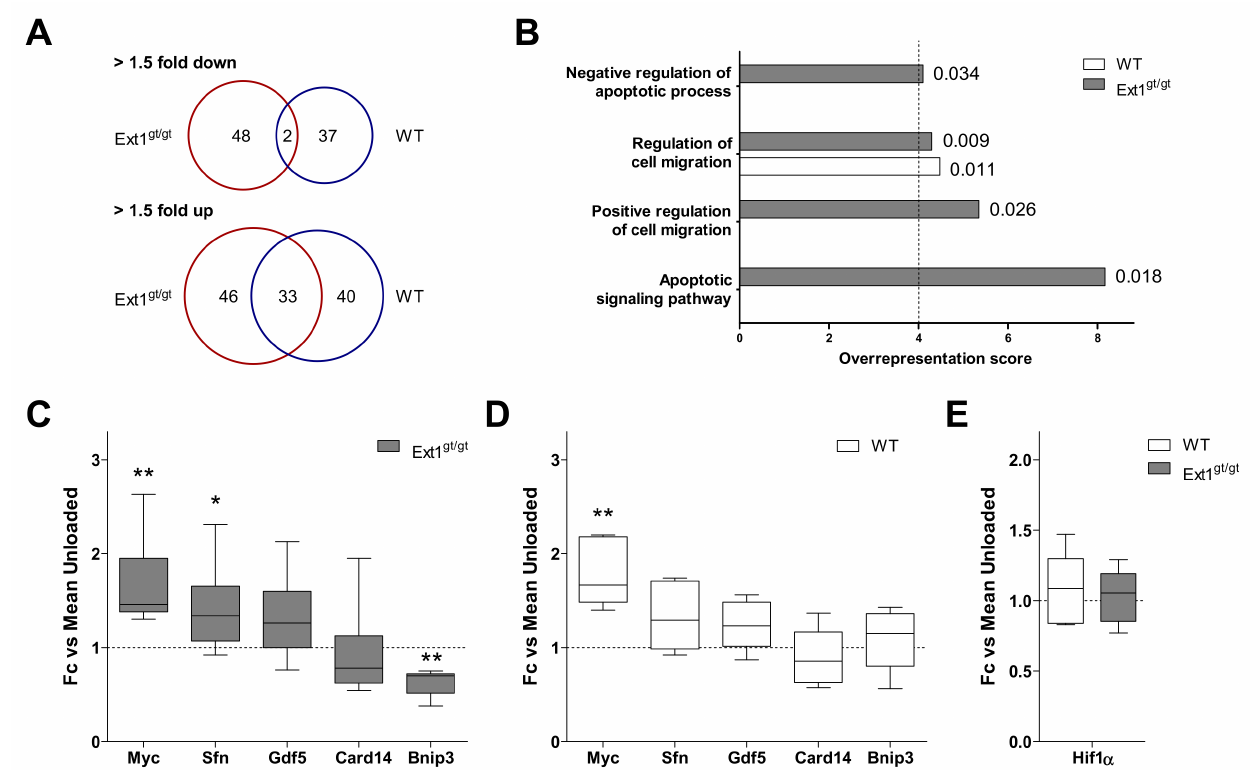
Figure 5. Regulation of mRNA expression (>1.5-fold) in response to loading in HS-deficient and WT cartilage. Microarray data were filtered for genes with a more than 1.5-fold differential expression between loaded and non-loaded samples. ( A ) Venn diagrams are shown, illustrating the differential and overlapping regulation of mRNAs (>1.5-fold) in Ext1 gt/gt vs. WT samples by loading. Numbers in Venn diagrams designate the number of regulated genes per group. ( B ) PANTHER statistical overrepresentation analysis for Ext1 gt/gt and WT cartilage of all genes with a more than 1.5-fold difference in mean expression levels between loaded and non-loaded specimens according to microarray data. Depicted are all Gene Ontology (GO) Biological Process categories with at least 4-fold significant overrepresentation (dashed line) in either genotype according to their overrepresentation score. Numbers behind bars indicate the respective p -values. ( C , D ) Expression levels of mRNAs (selection from Table 2) in engineered Ext1 gt/gt ( C ) and WT ( D ) cartilage in response to loading. ( E ) Expression levels of Hif1 α mRNA in Ext1 gt/gt and WT cartilage in response to loading. RT-qPCR analysis was performed as described in Figure 3. Data are shown as box plots as described in Figure 1 ( n = 6, 5 donors). Loaded vs. non-loaded: Mann–Whitney U test * p < 0.05, ** p <